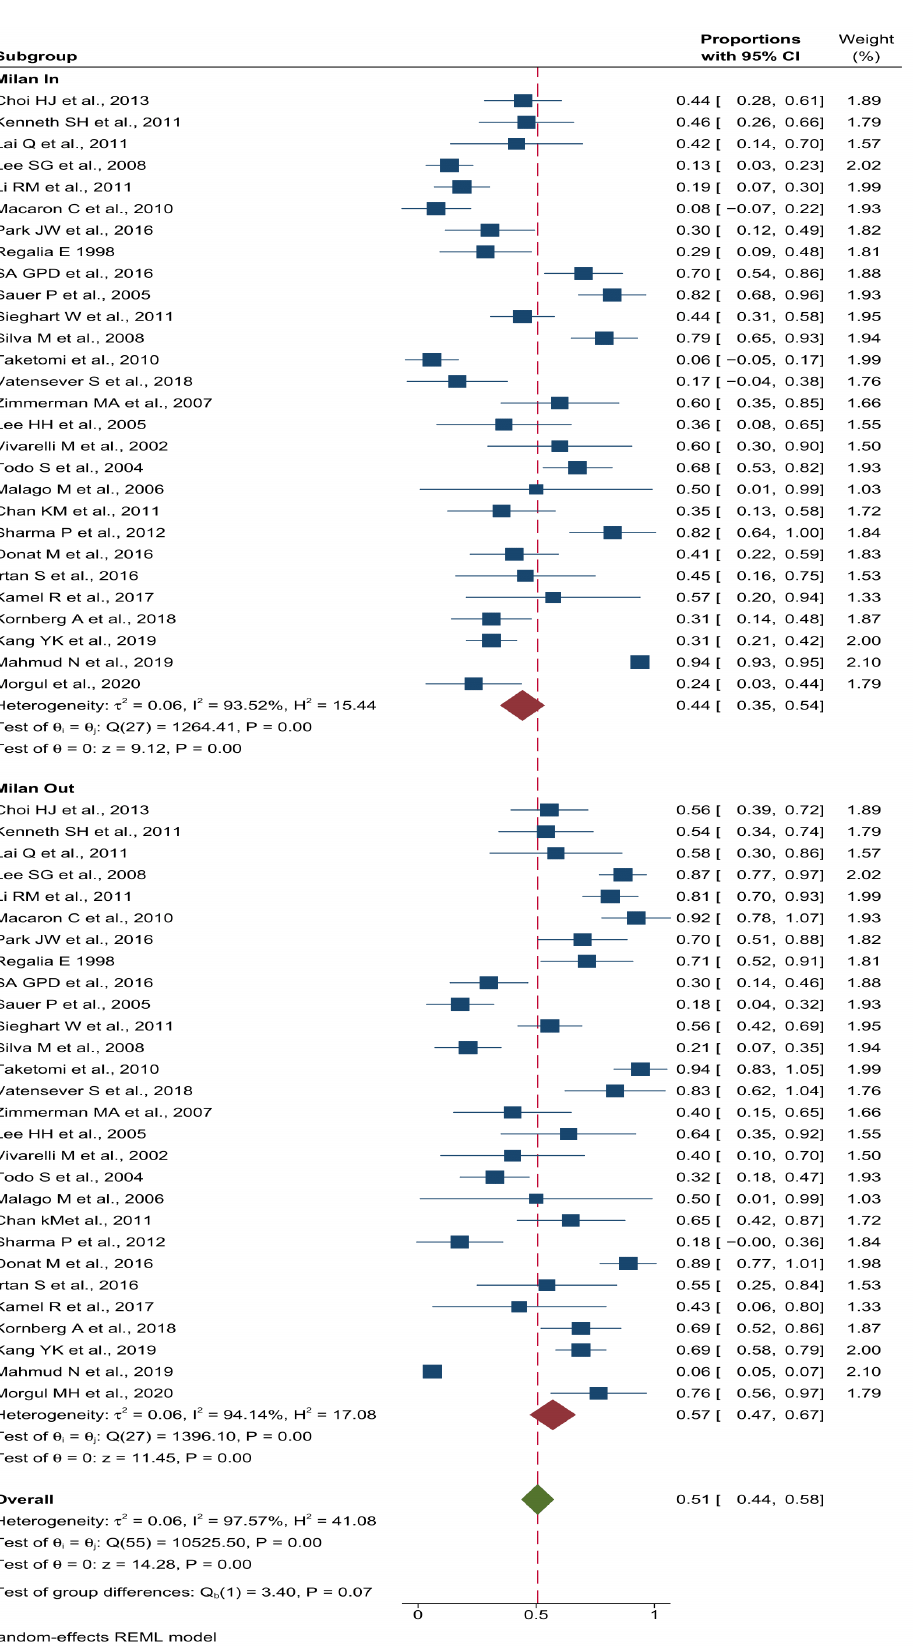
Figure 3. Pooled prevalence stratified by Milan criteria in patients with HCC recurrence after LT.